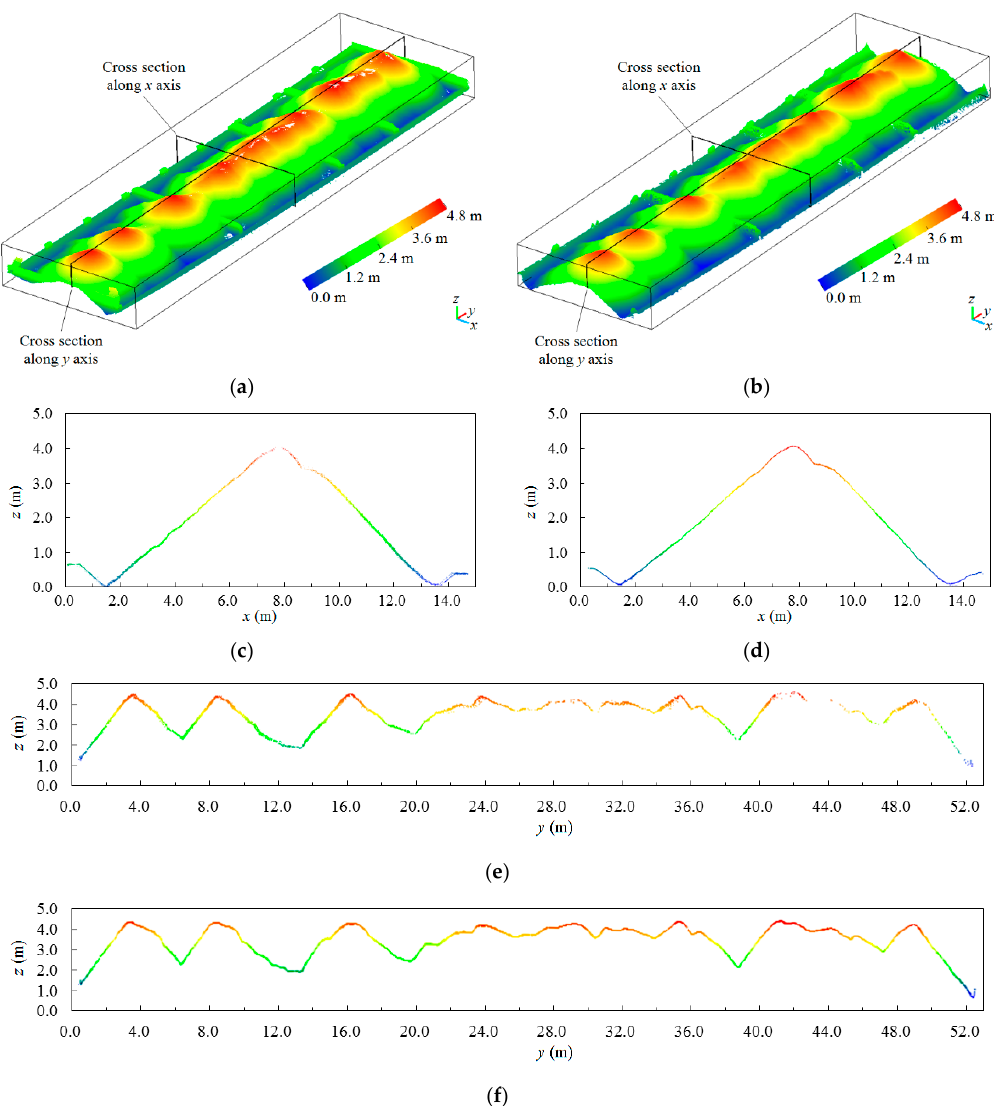
Figure 12. Comparisons of point clouds generated from laser scanning and UAV photogrammetry for stockpile-free modeling: ( a ) and ( b ) are the point clouds generated from laser scanning and UAV photogrammetry, respectively; ( c ) and ( d ) are the respective cross sections of ( a ) and ( b ) along the x-axis; ( e ) and ( f ) are the respective cross sections of ( a ) and ( b ) along the y-axis.